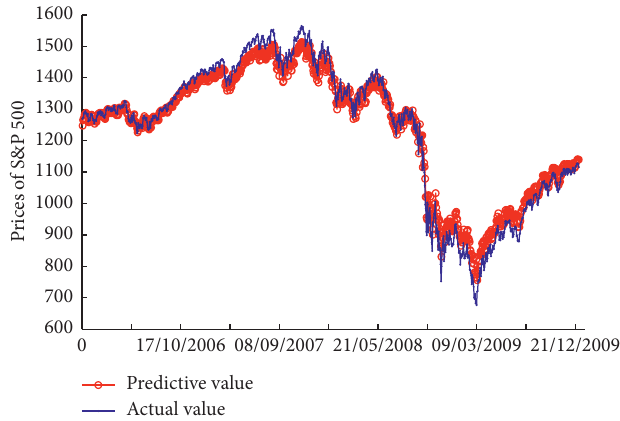
Figure 4: Comparisons of prediction results and the daily closing prices of S&P 500 for testing